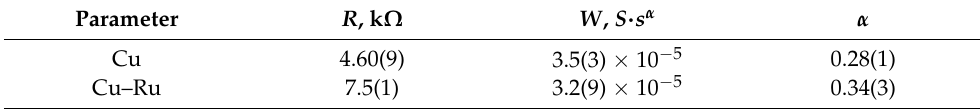
Figure 6. The admittance loci and their CNLS-approximation for Cu ( a ) and Cu–Ru ( b ) electrodes. The black squares correspond to the experimentally obtained admittance spectra using the FFT-EIS, and the red circles denote the CNLS fitting of the experimental data with an equivalent scheme shown in Figure 2. As one can see, the admittance spectra of all electrodes have an arc shape indicating that the surfaces of these electrodes are developed and porous. The difference in the shape of the spectra is associated with different values of α caused by different pore sizes and the structure of the studied electrodes (see Figure 3 and Table 2). Table 2. Typical results of the CNLS fitting of the admittance spectra of Cu-based electrodes. The ac- curacy is calculated as 99% confidence